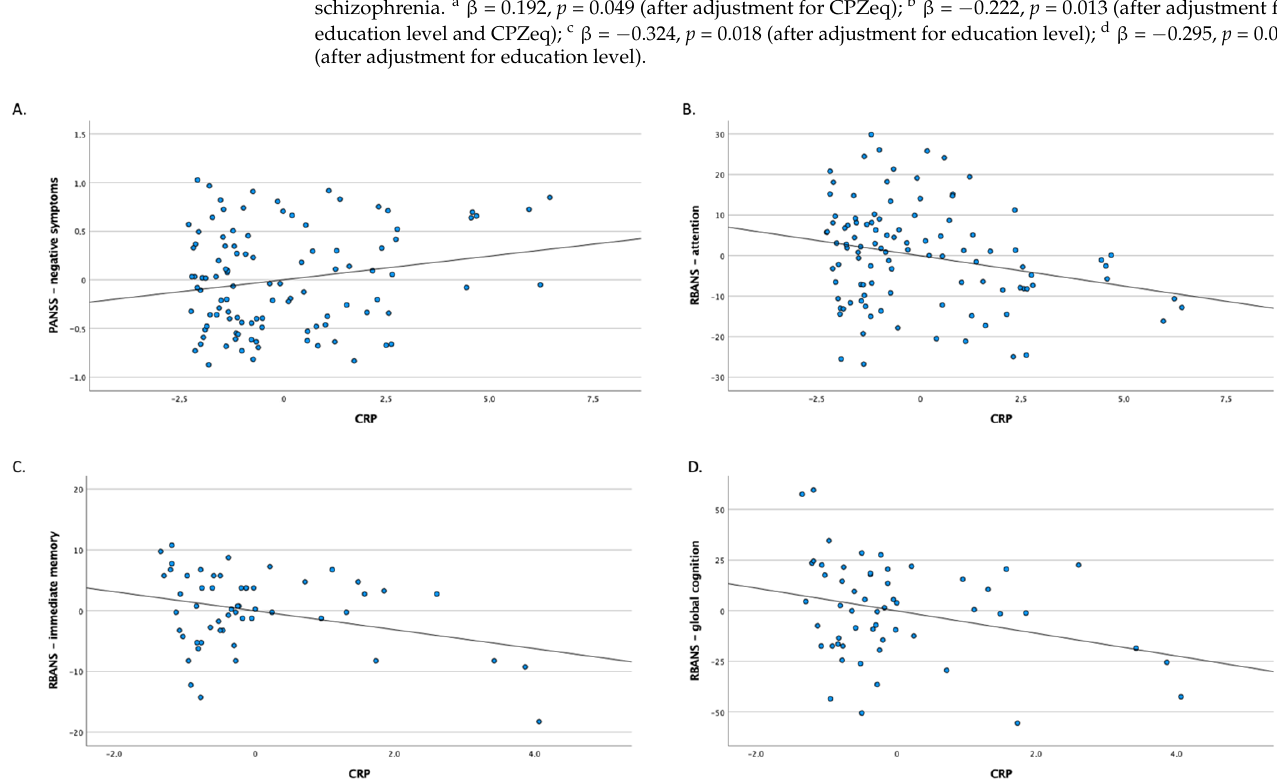
Figure 1. Partial regression plots showing correlation of CRP levels in the whole sample of patients with schizophrenia ( A , B ) and healthy controls ( C , D